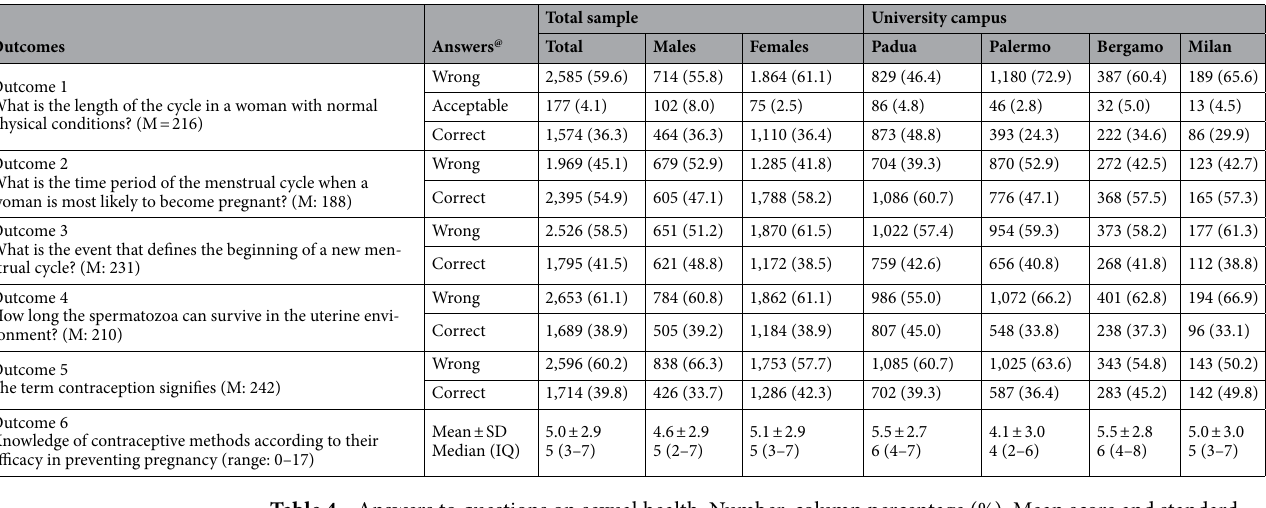
Table 4. Answers to questions on sexual health. Number, column percentage (%), Mean score and standard deviation (SD), M = missing values (blanks). @ See